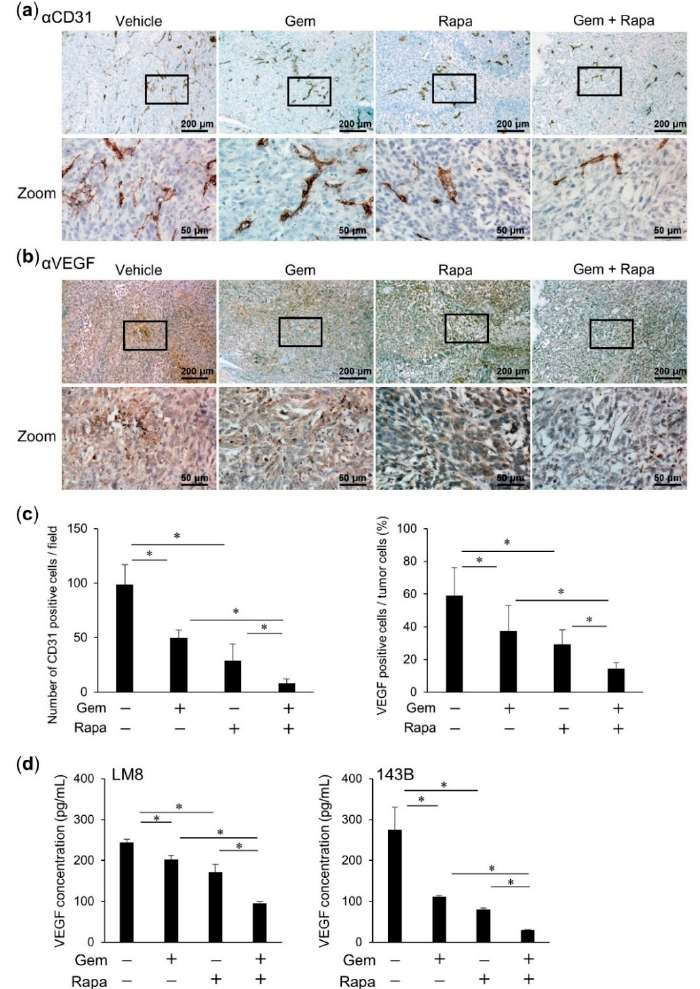
Figure 8. Combined administration of Gem and Rapa reduced angiogenesis and Vascular Endothelial Growth Factor (VEGF) production. Primary tumors were resected at day 28 post-transplantation of LM8 cells. Angiogenesis was evaluated by IHC against CD31 ( a ) and VEGF ( b , c ) Cells positive for CD31 and VEGF were counted and quantified. Bar = 200 μ m in the upper panels. Bar = 50 μ m in the lower panels. ( d ) LM8 and 143B cells were treated with Gem alone or in combination with Rapa. The levels of VEGF in the supernatant were determined using ELISA. Results are shown as the mean ± SD. * p < 0.05.